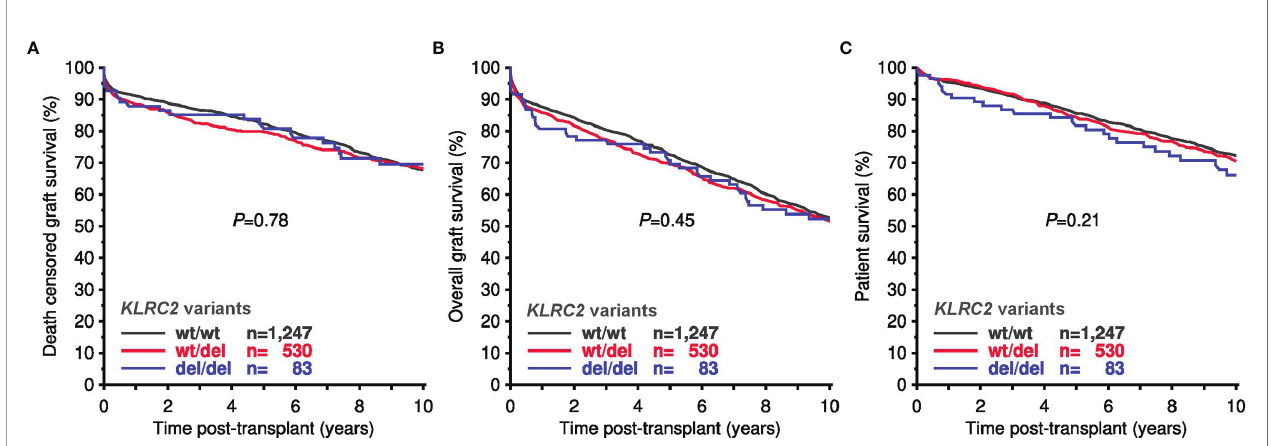
TABLE 5 | Multivariable Cox regression analysis for in fl uence of number of KLRC2 -wild type alleles on 10-year graft and patient survival in the CTS cohort. Population Patients Death-censored graft survival